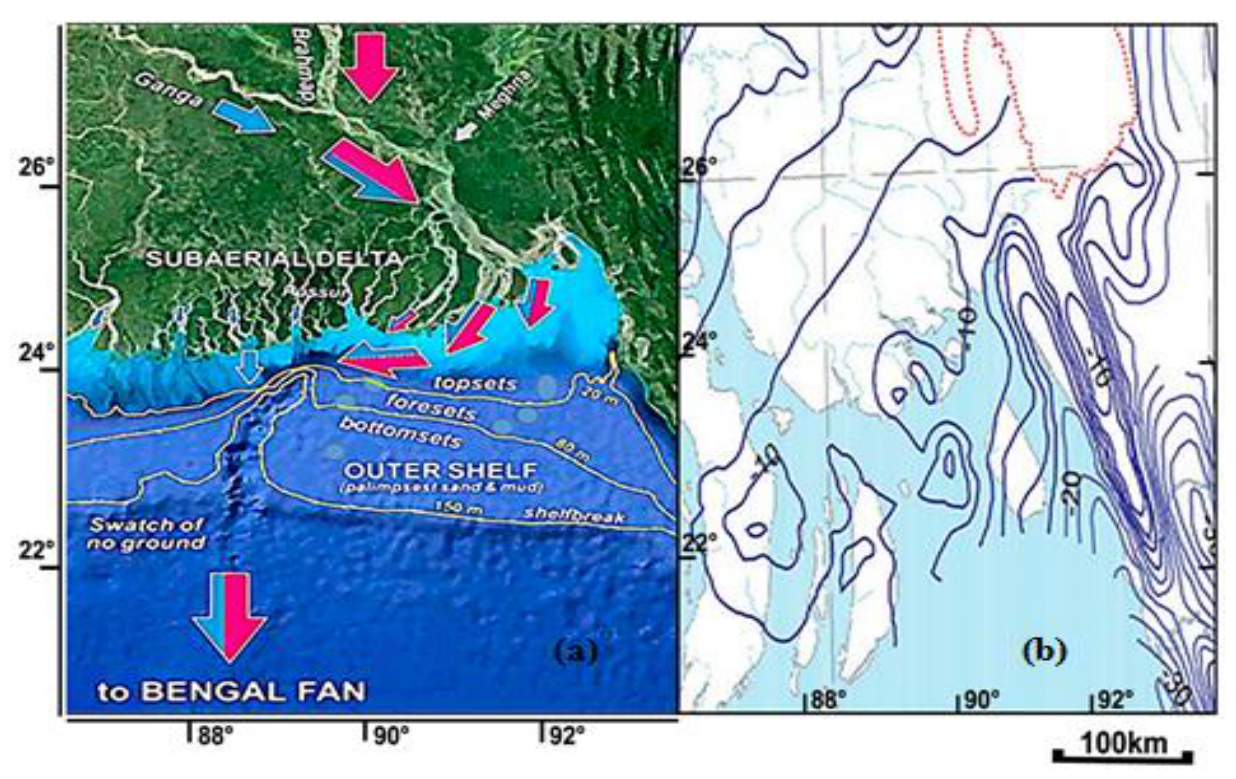
Figure 1. ( a ). Sediment in transit across the Bengal system [27 – 31], ( b ). Map of the Hatiya Trough region of the Bengal Basin showing the Bouguer gravity anomalies (Lambert Conformal Conic with Everest 1969 spheroid) [32].